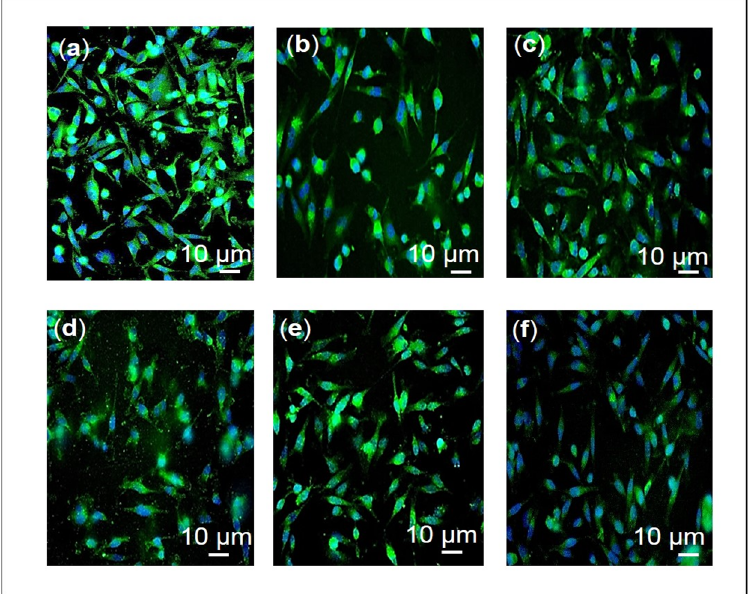
Figure 11. Fibronectin protein expression. The representative fluorescence image of MDA-MB-231 cells treated with the indicated concentrations ( b ) F3, ( c ) lutein, ( d ) β -sitosterol, and ( e ) stigmasterol for 24 h was compared to ( a ) control (untreated cells). Tamoxifen ( f ) was used as a positive control. Cells were observed at 400× magnification.